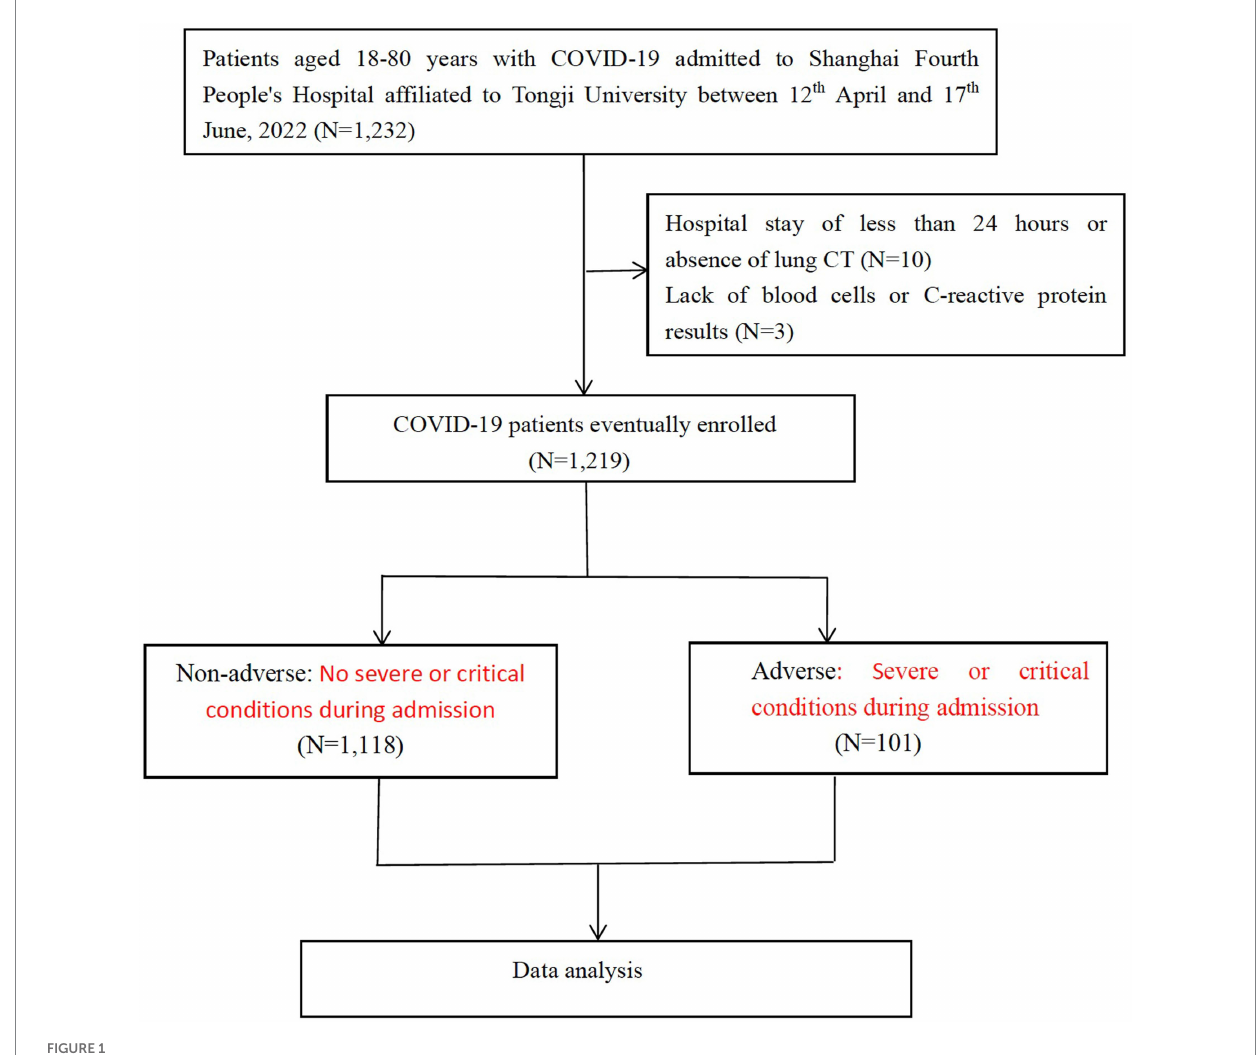
FIGURE 1 Flow chart of patient recruitment, clinical screening, and